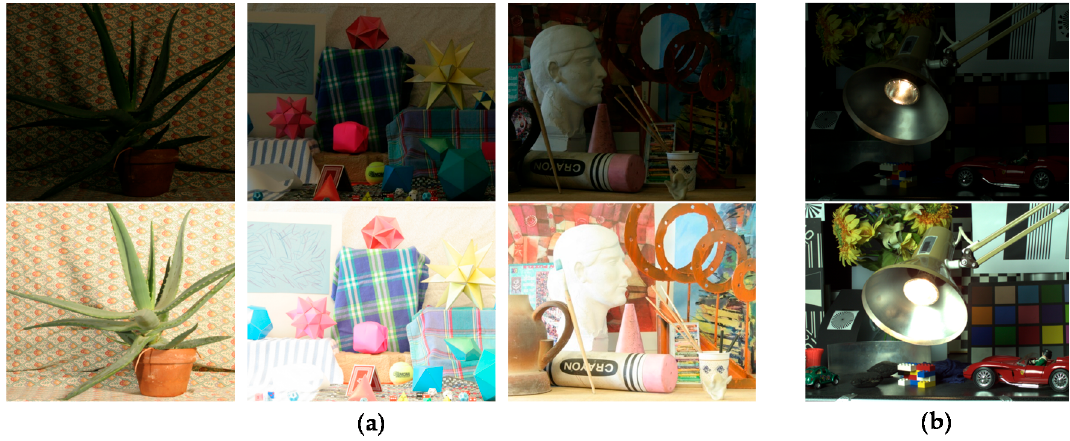
Figure 17. Input image pairs with short-long exposure: ( a ) input Middlebury images; and ( b ) input IIS Jumble images.